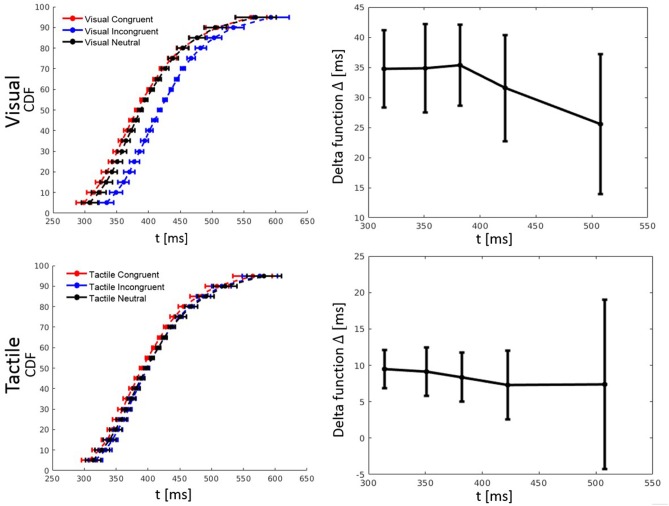
Cumulative distribution functions (CDFs) and delta (Δ) functions for percentiles (5, 10, 15, …, 95%) in Experiment 1. Error bars show 95% confidence intervals and are calculated according to Morey (2008). Each of the visual (tactile) CDFs was calculated as the average over all tactile (visual) congruency conditions. For example, the visual congruent CDF is the average of CVCT, CVNT, and CVIT conditions. Delta functions show the difference between the congruent and incongruent CDFs as a function of response time.